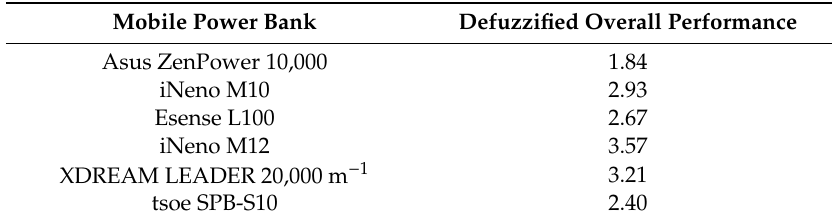
Table 10. Assessment results using fuzzy geometric mean-fuzzy geometric mean-fuzzy weighted average